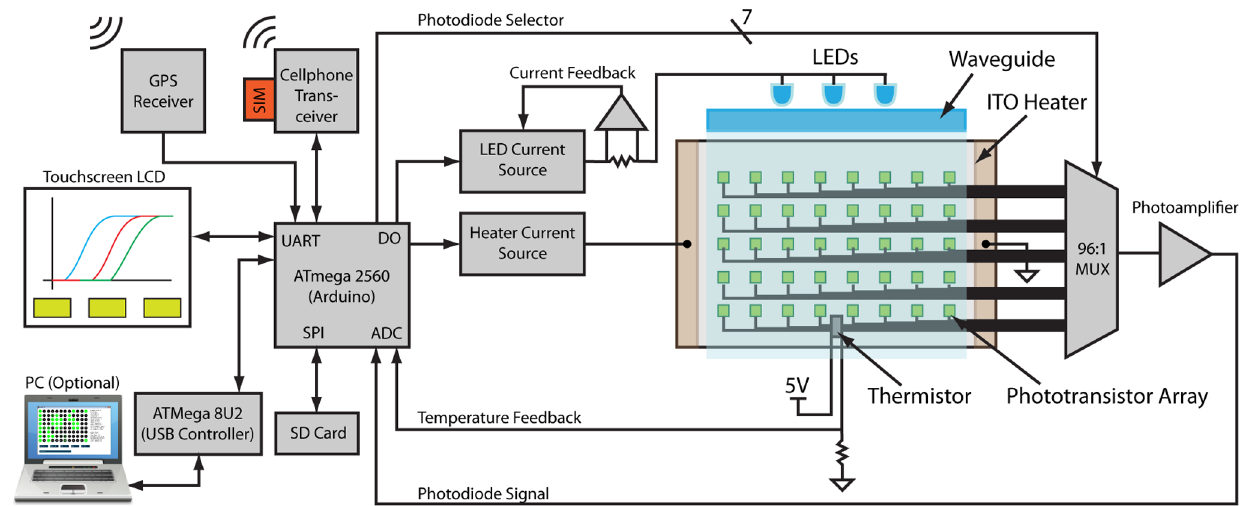
Figure 2. Block diagram of the m BAR system. The system is controlled by an ATmega 2560 microcontroller which has been loaded with the Arduino bootloader firmware. A GPS receiver and cell phone transceiver facilitate remote field diagnostics and epidemiological studies. The system can receive user input via either an LCD touchscreen or PC via USB. Data is stored to an SD card and also broadcast to the PC, if connected. A monolithic LED driver supplies a constant current to 3 blue InGaAs LEDs (even as battery voltage decreases), and a booster circuit delivers a constant current to the ITO heater. The microcontroller receives temperature feedback from a thermistor and turns the heater on and off accordingly. An array of 96 phototransistors are positioned underneath the heater and an analog multiplexer is used to raster across the array and read photocurrents from each location using a single photoamplifier.